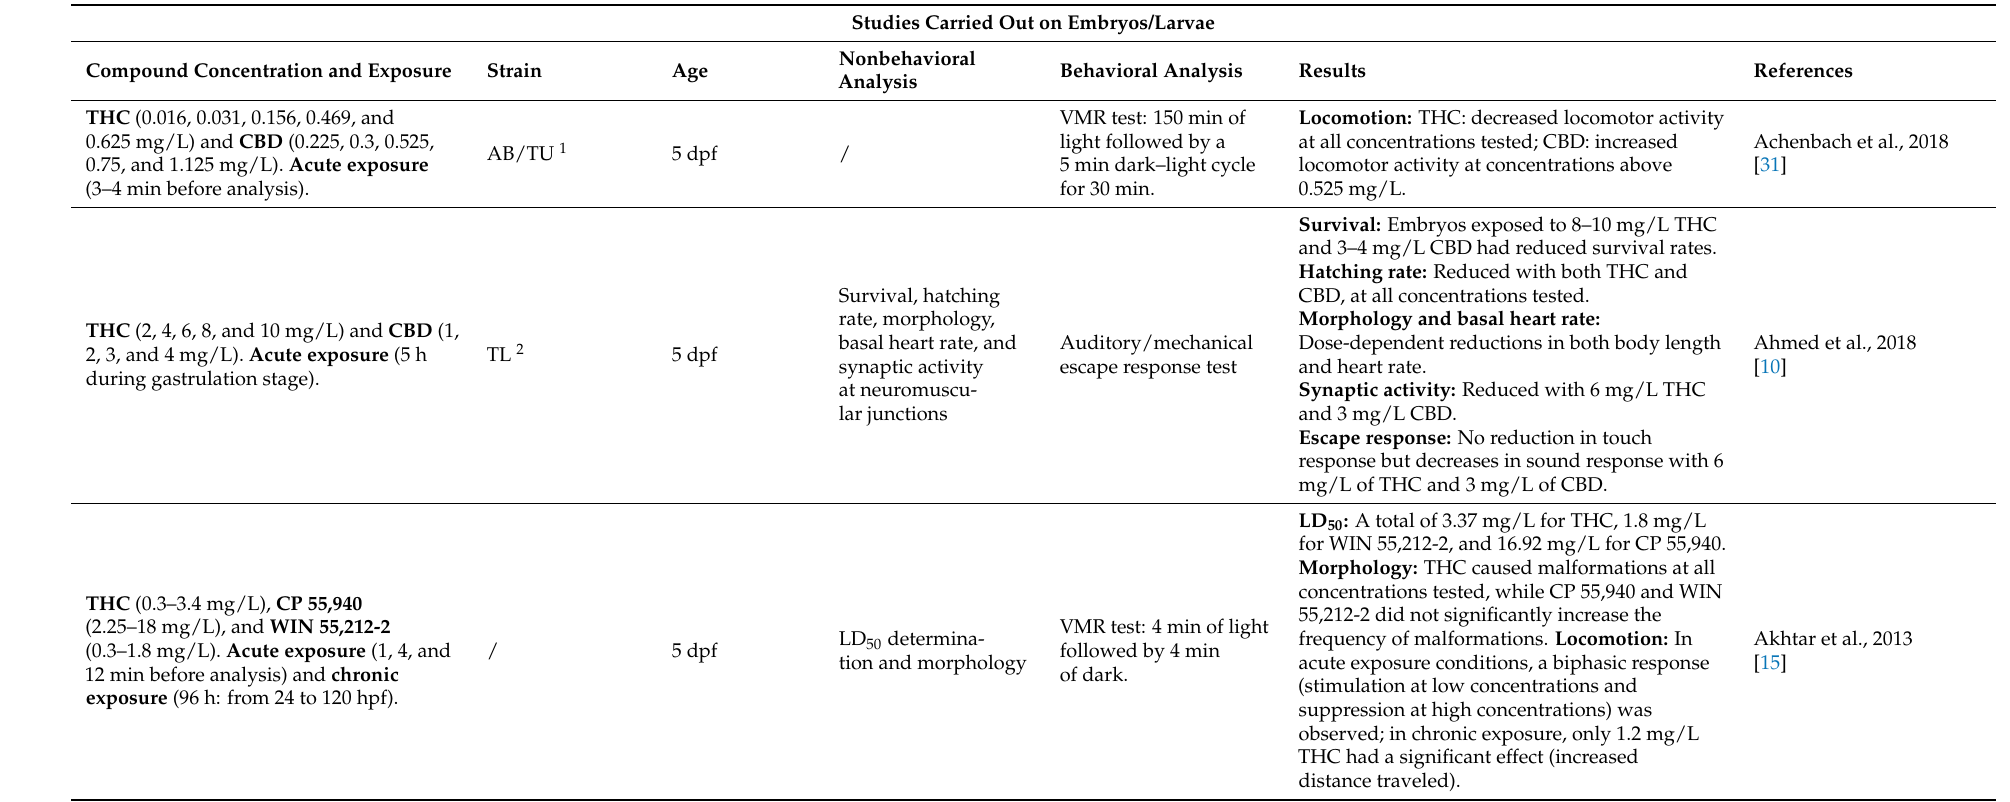
Table 1. An overview of cannabis-exposure effects in